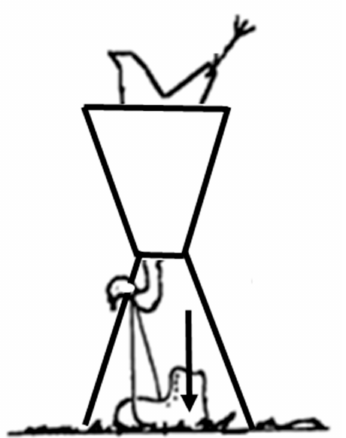
Figure 1. Mechanically-assisted cervical dislocation for turkeys. The bird is restrained in a cone (inverted position). A nylon cord is looped (600 mm) over and behind the head at the cranial/vertebral (C0/C1) junction. Holding the head firmly in place (by hand), the stockworker places his foot through the lower part of the loop situated beneath the bird (off the ground) and forcefully and quickly presses his foot to the floor causing a rapid dislocation of the